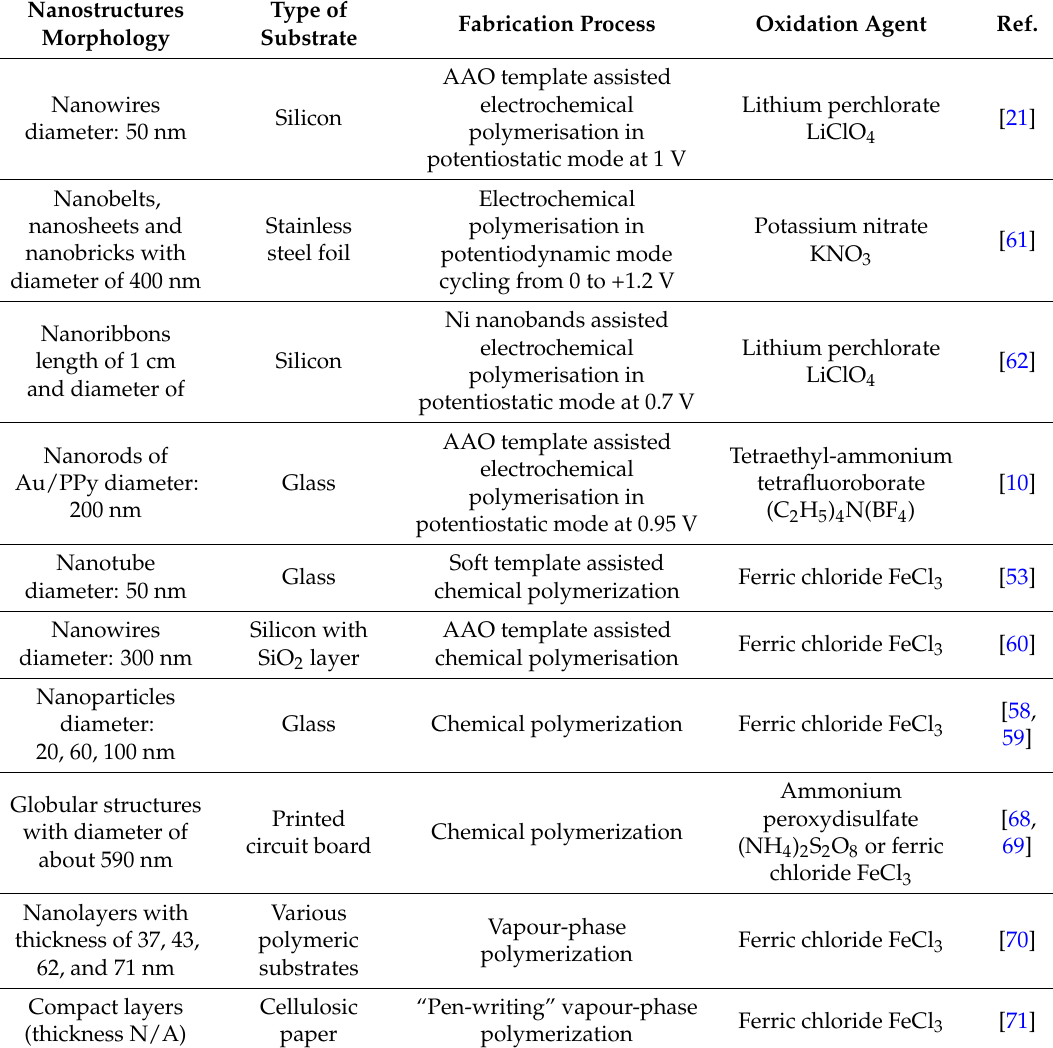
Table 2. Overview of preparation methods of PPy nanostructured sensing